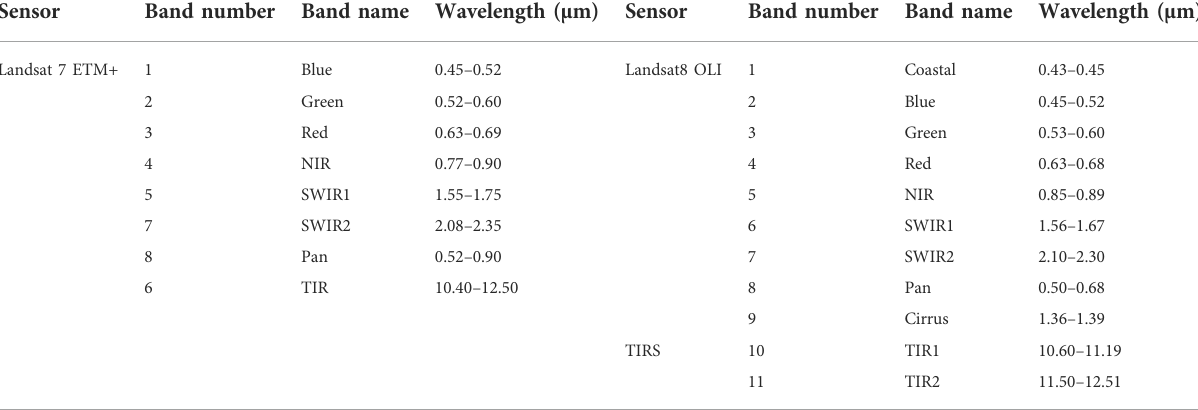
TABLE 1 Landsat 7/8 image data band setting.